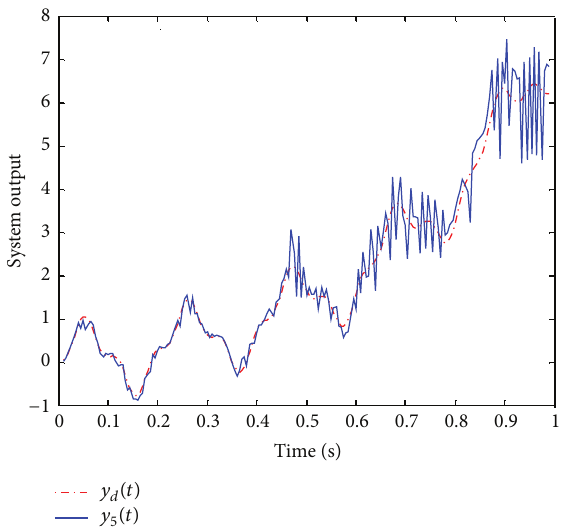
Figure 3: System output trajectory at 10th iteration for Example 1.